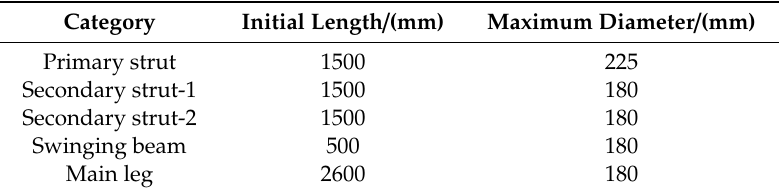
Table 6. Structure parameter of the ML.